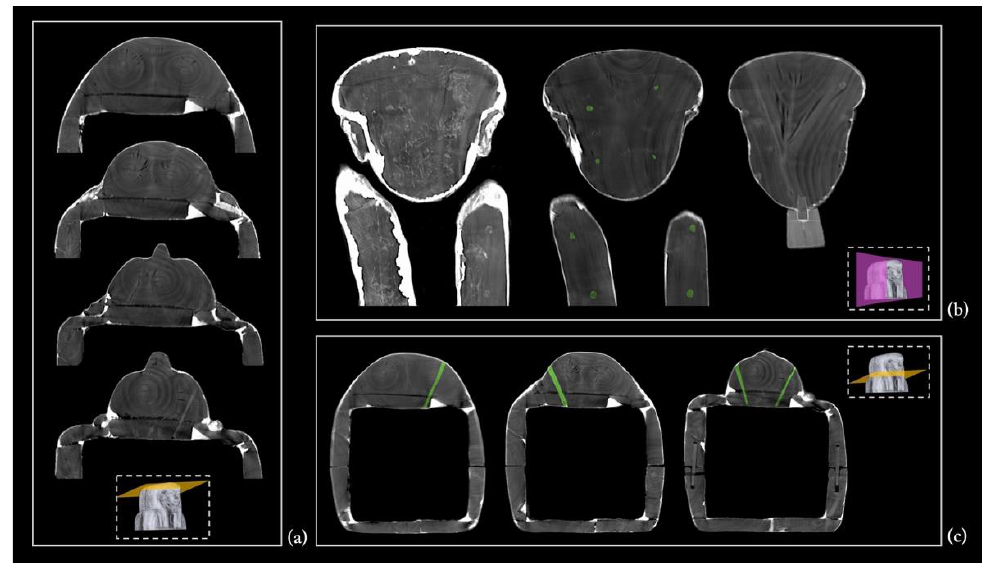
Figure 9. ( a ) The two splayed piths in the wooden block of the face; ( b , c ) face, ears, beard, and wig’s lappets joined by means of glue, plaster-like materials, and dowels.